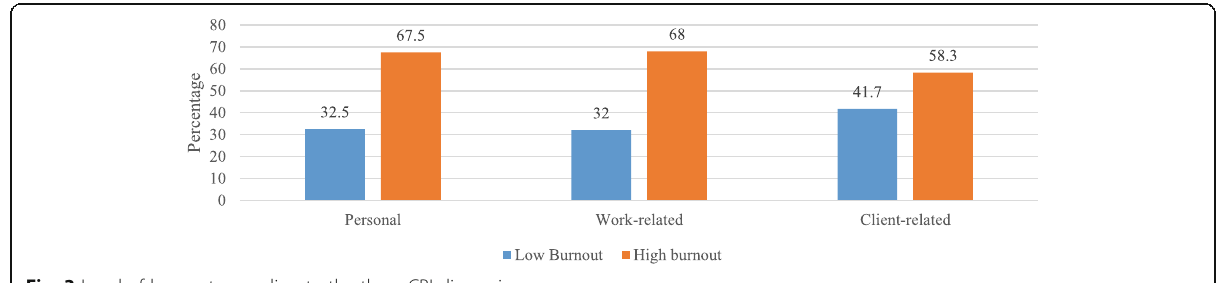
Fig. 3 Level of burnout according to the three CBI